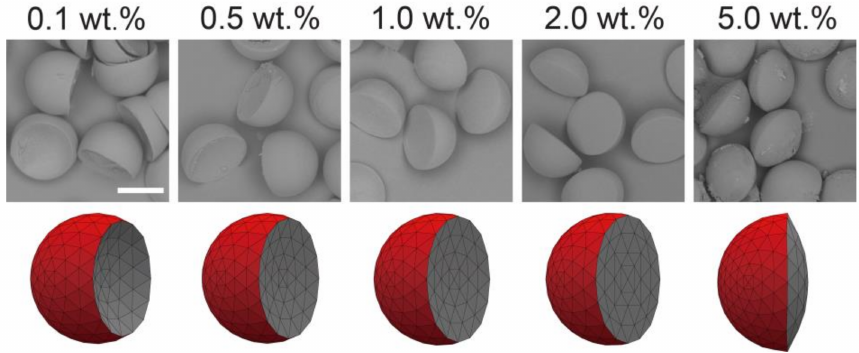
Figure 7. Scanning electron microscopy images of concave-convex, planar-convex, and biconvex particles ( top ), and their simulated models ( bottom ) prepared at different surfactant concentrations in silicone oil segments. Precursor Janus droplets were produced at Q m = Q s = 0.3 mL h − 1 , and Q c = 8.0 mL h − 1 . Scale bar: 100 µ m.